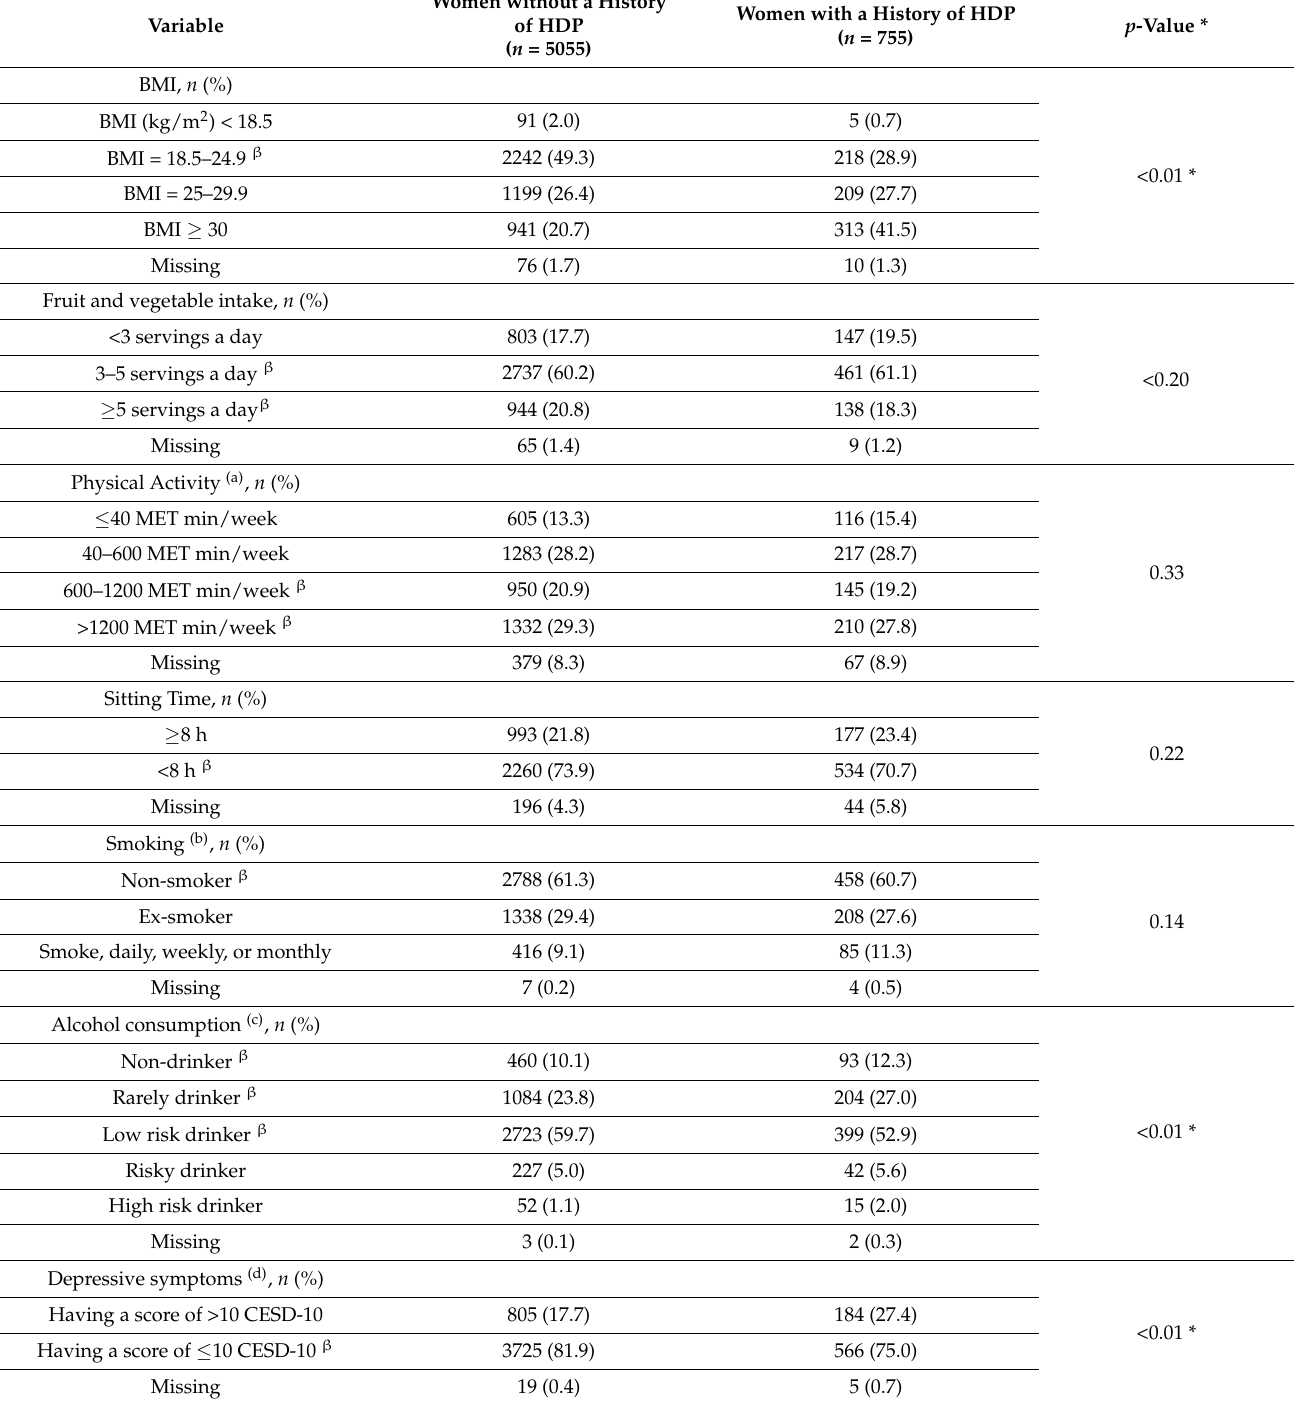
Table 3. Rates of individual CVD risk factors in both women with and without a history of